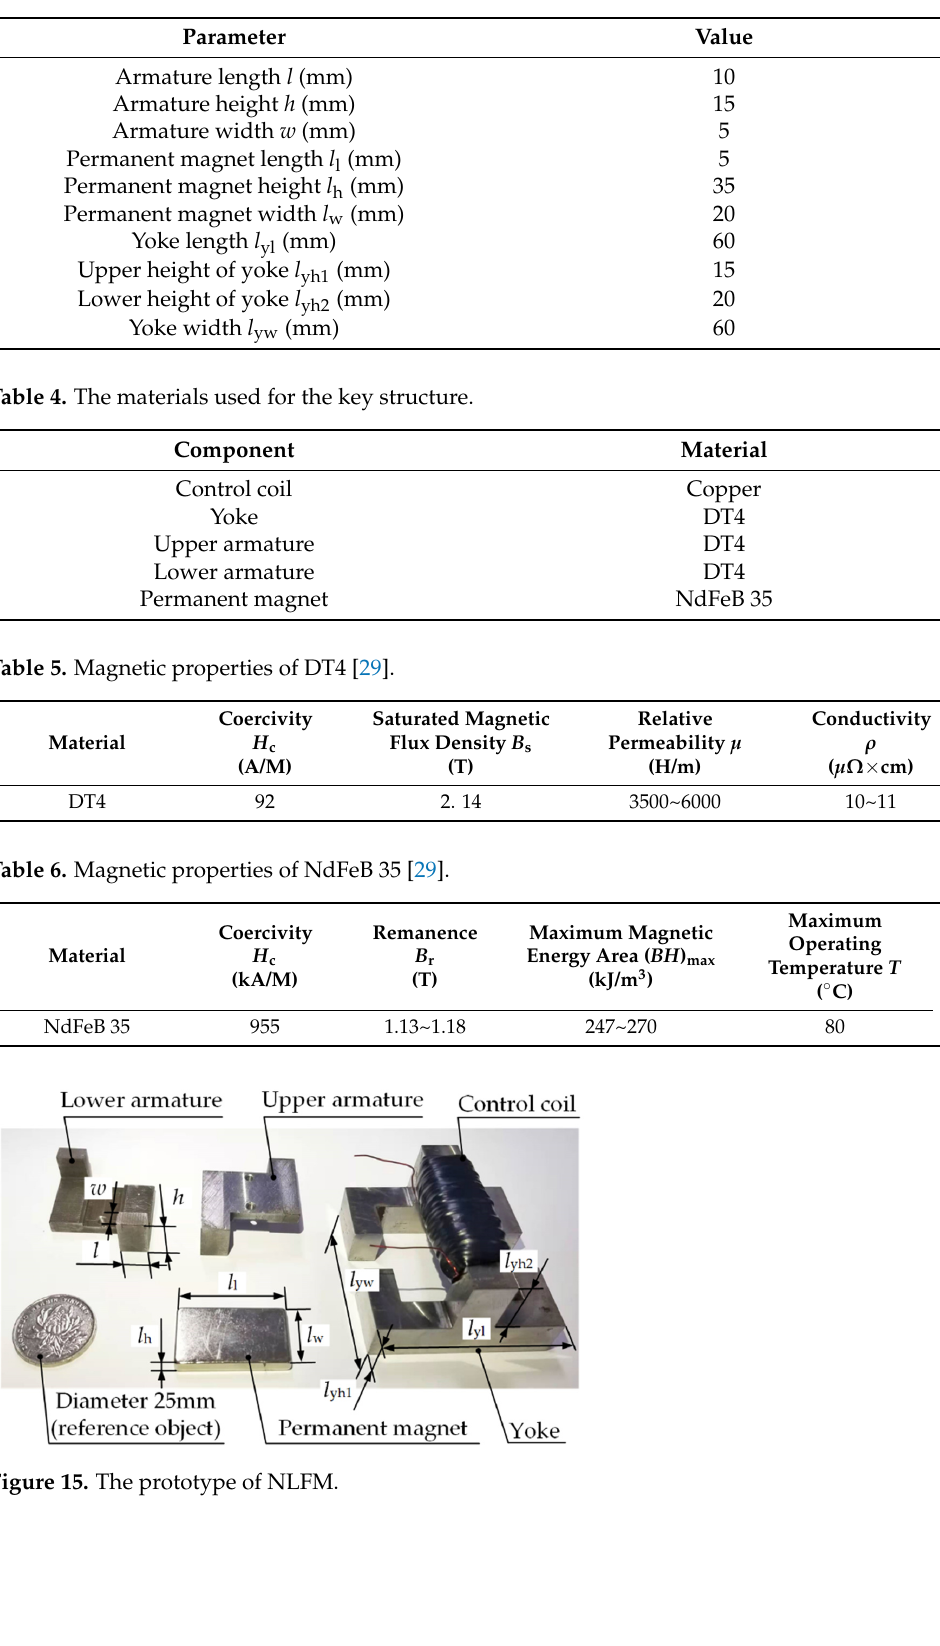
Table 3. Key structural parameters of the NLFM prototype.